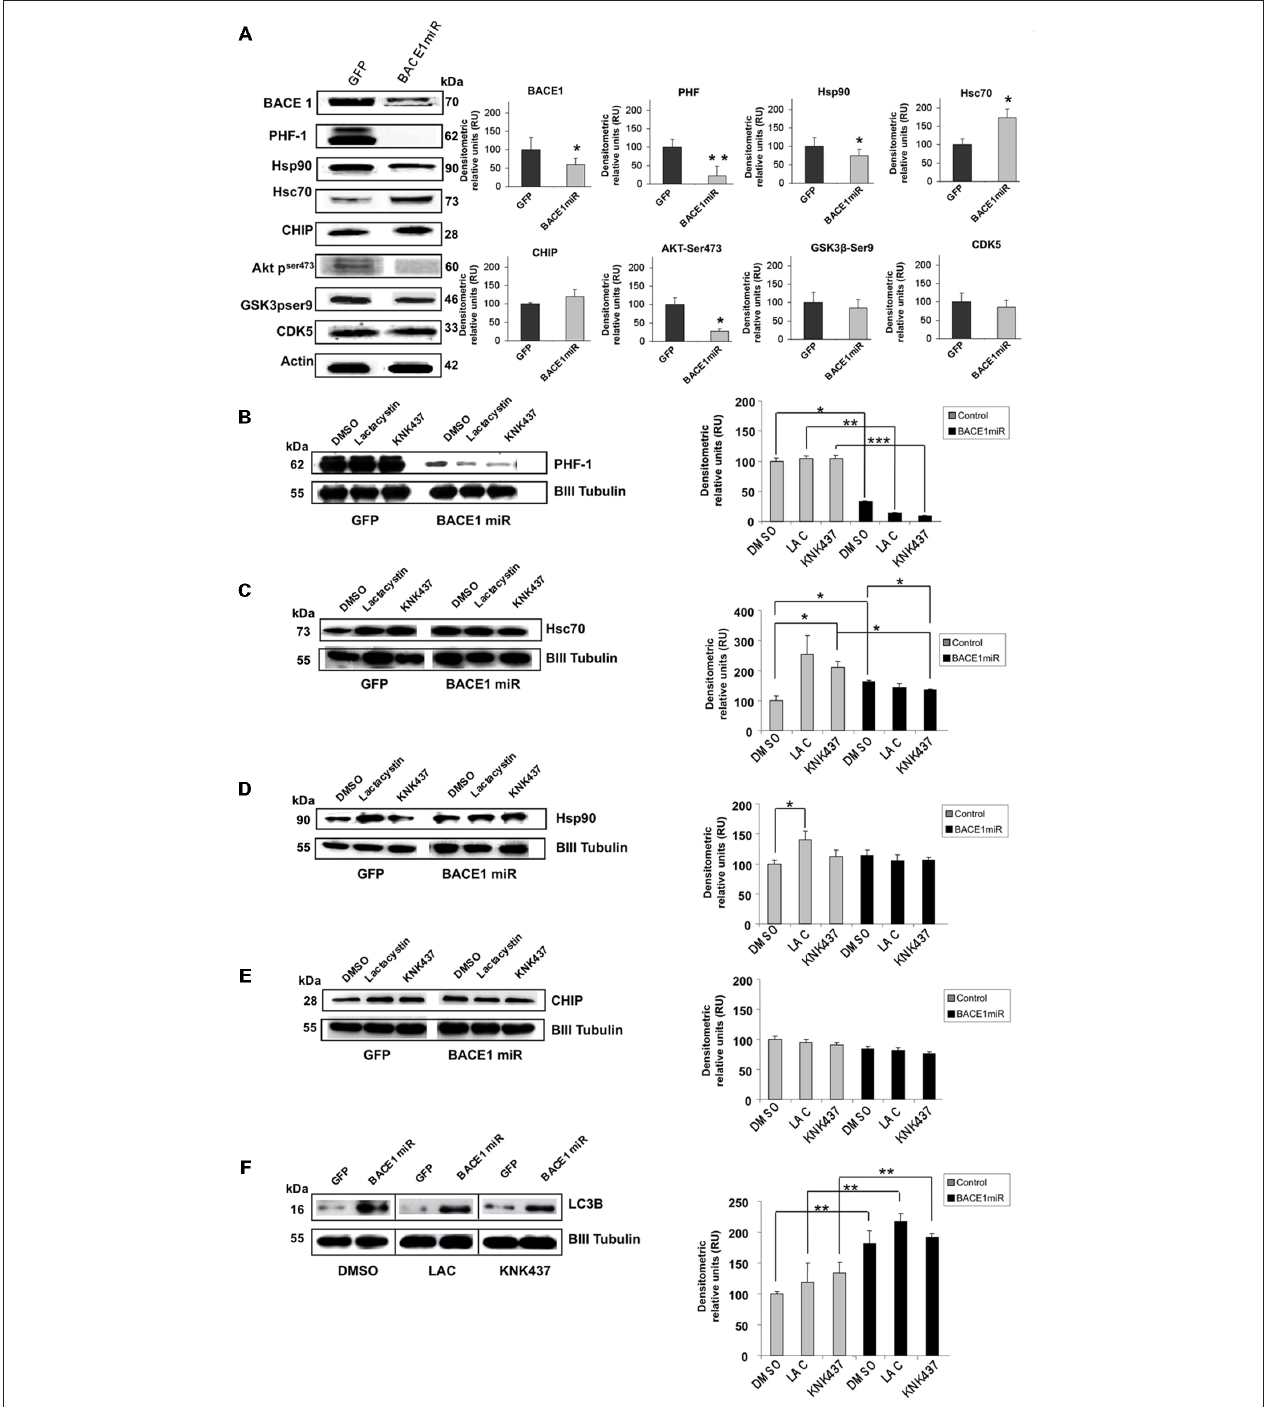
FIGURE 5 | BACE1miR decreased hyper-phosphorylated tau in a proteosome-independent manner in primary neuronal cultures. (A) BACE1, PHF-1, Hsp90, Hsc70, CHIP, pAkt (ser473), GSK3 (pSer9) and CDK5 Western blots from primary neuronal cultures transduced at DIV5 (7 days transduction) with AAV2/5-BACE1miR or AAV2/5-GFP as a control. Representative blots are shown. Actin was used as a loading control. Densitometric quantification was performed; RU = relative units. n = 4, ∗ p < 0.05, ∗ p < 0.001. (B) Western blotting of primary cortical cultures transduced with AAV2/5-BACE1miR or AAV2/5-GFP at DIV5 for 7 days. Neurons were exposed to lactacystin (synthetic; 10 µ M), KNK437 heat shock protein inhibitor I, (100 µ M) or DMSO for 24 h. Representative blots of (B) PHF-1, (C) Hsc70, (D) Hsp90, (E) CHIP and (F) LC3-B. β III-tubulin was used as a loading control. Densitometric quantification was performed; RU = relative units. n = 4, ∗ p < 0.05, ∗∗ p < 0.001, ∗∗∗ p < 0.0001.